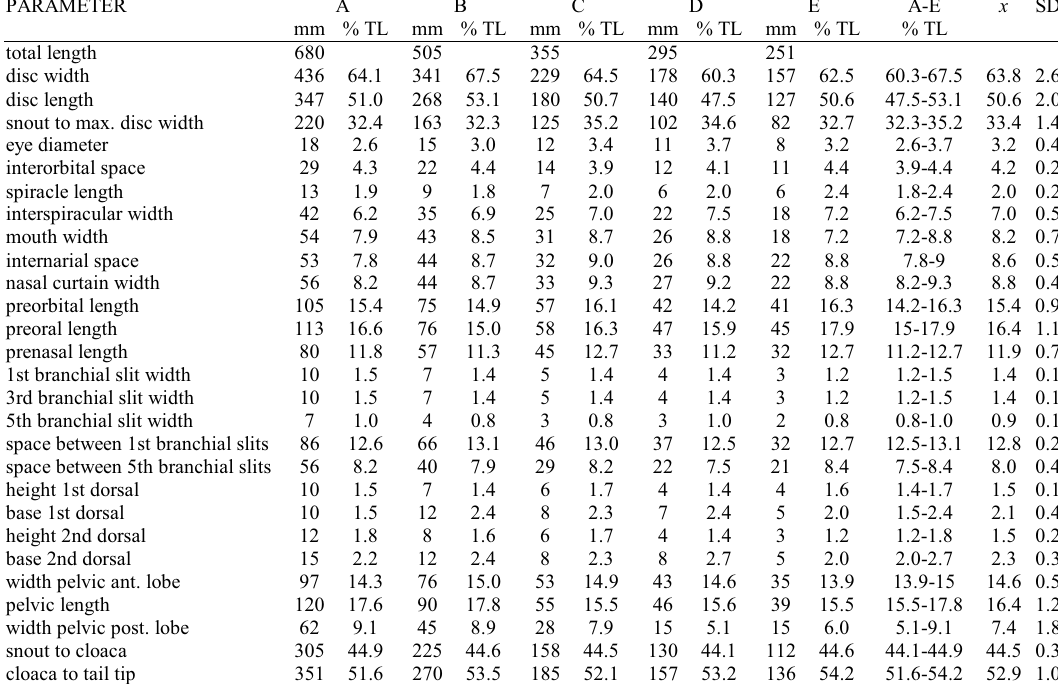
Table 1. Measurements of all specimens of M . obscura in mm and proportions of total length (% of TL). A: MNRJ 28289, holotype, adult female. B: MNRJ 28290, paratype, subadult male. C: MNRJ 28291, paratype, juvenile male. D: MNRJ 28292, paratype, juvenile male. E: MNRJ 28293, paratype, juvenile female. A–E: range. x : mean. SD: standard